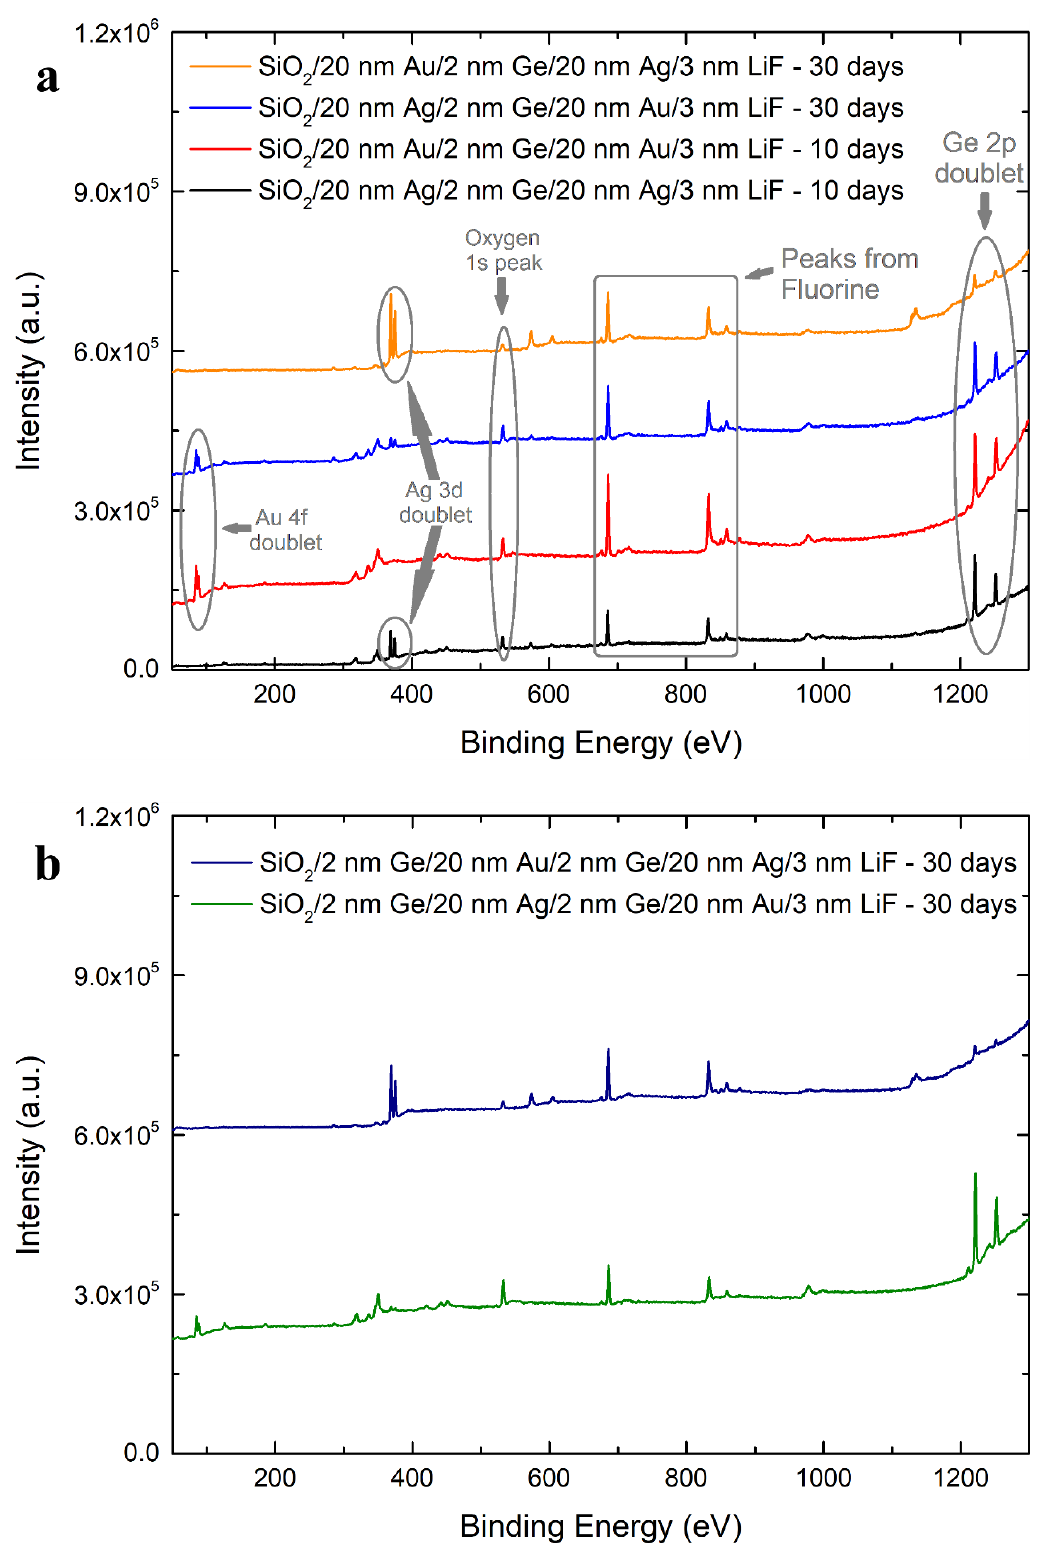
Figure 1. ( a ) X-ray photoelectron spectroscopy (XPS) spectra of sandwich-like structures where 2-nm-thick germanium film is deposited in between 20-nm-thick Ag and Au layers, when the Au is at the bottom (orange curve) or at the top (blue curve). For comparison, spectra for structures where the germanium is deposited between two layers of the same metal, from refs [38] and [39], are also presented. ( b ) XPS spectra of similar structures, but with an additional Ge film at the substrate/metal interface. The intensity curves on both figures are offset by different values for clarity of reading.